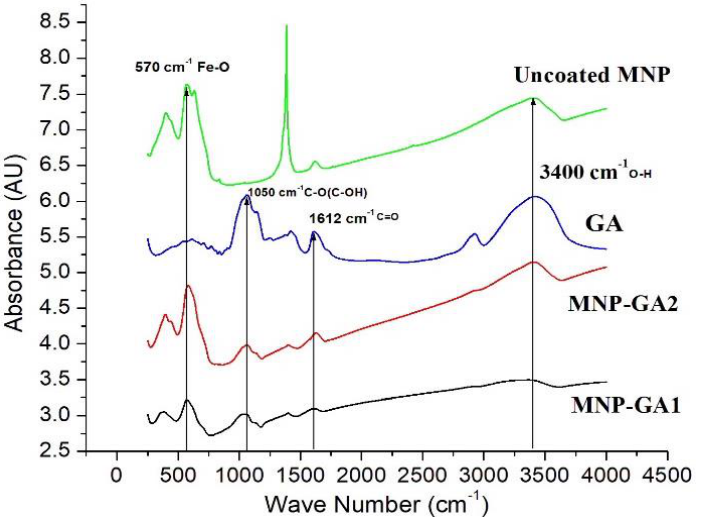
Figure 3. FT-IR spectra of the Fe 3 O 4 MNPs (green line), GA (blue line), MNP-GA2 (red line), MNP- GA1 (dark line).